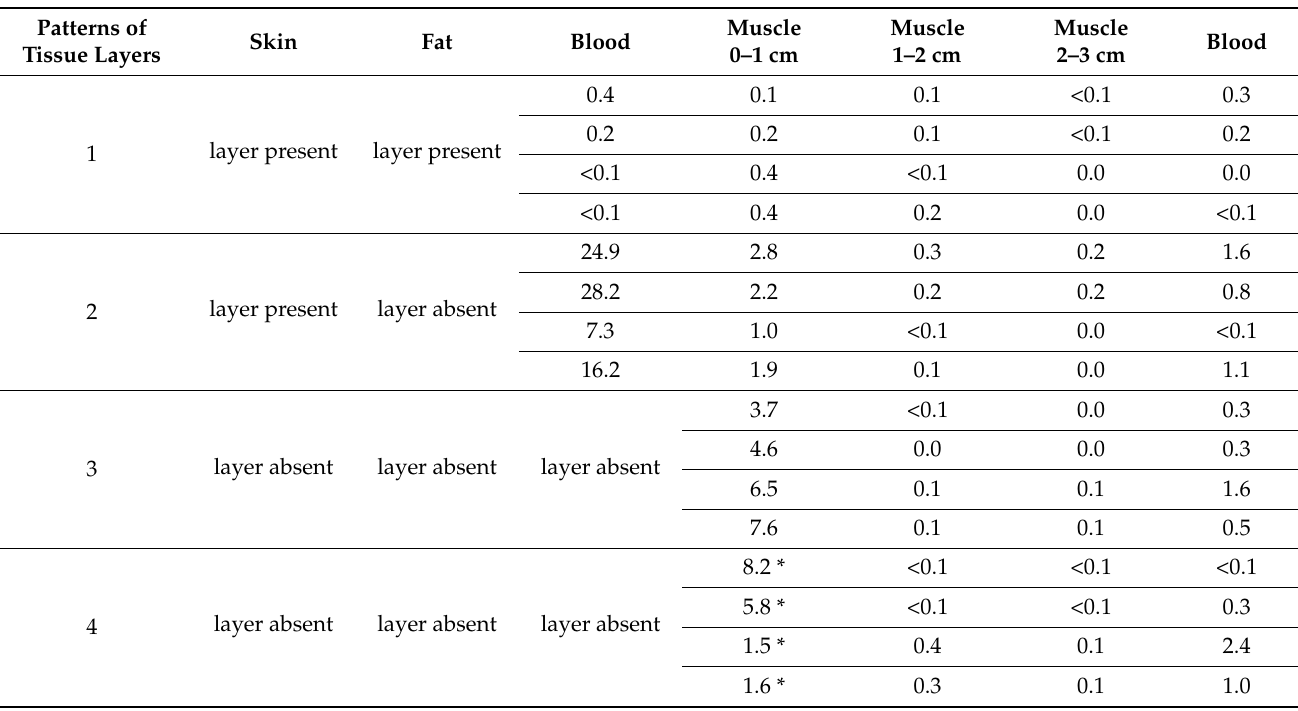
Table 1. Concentrations (% sat.) of COHb in blood and COMb in 3 layers of muscles after the 24 h CO exposure.